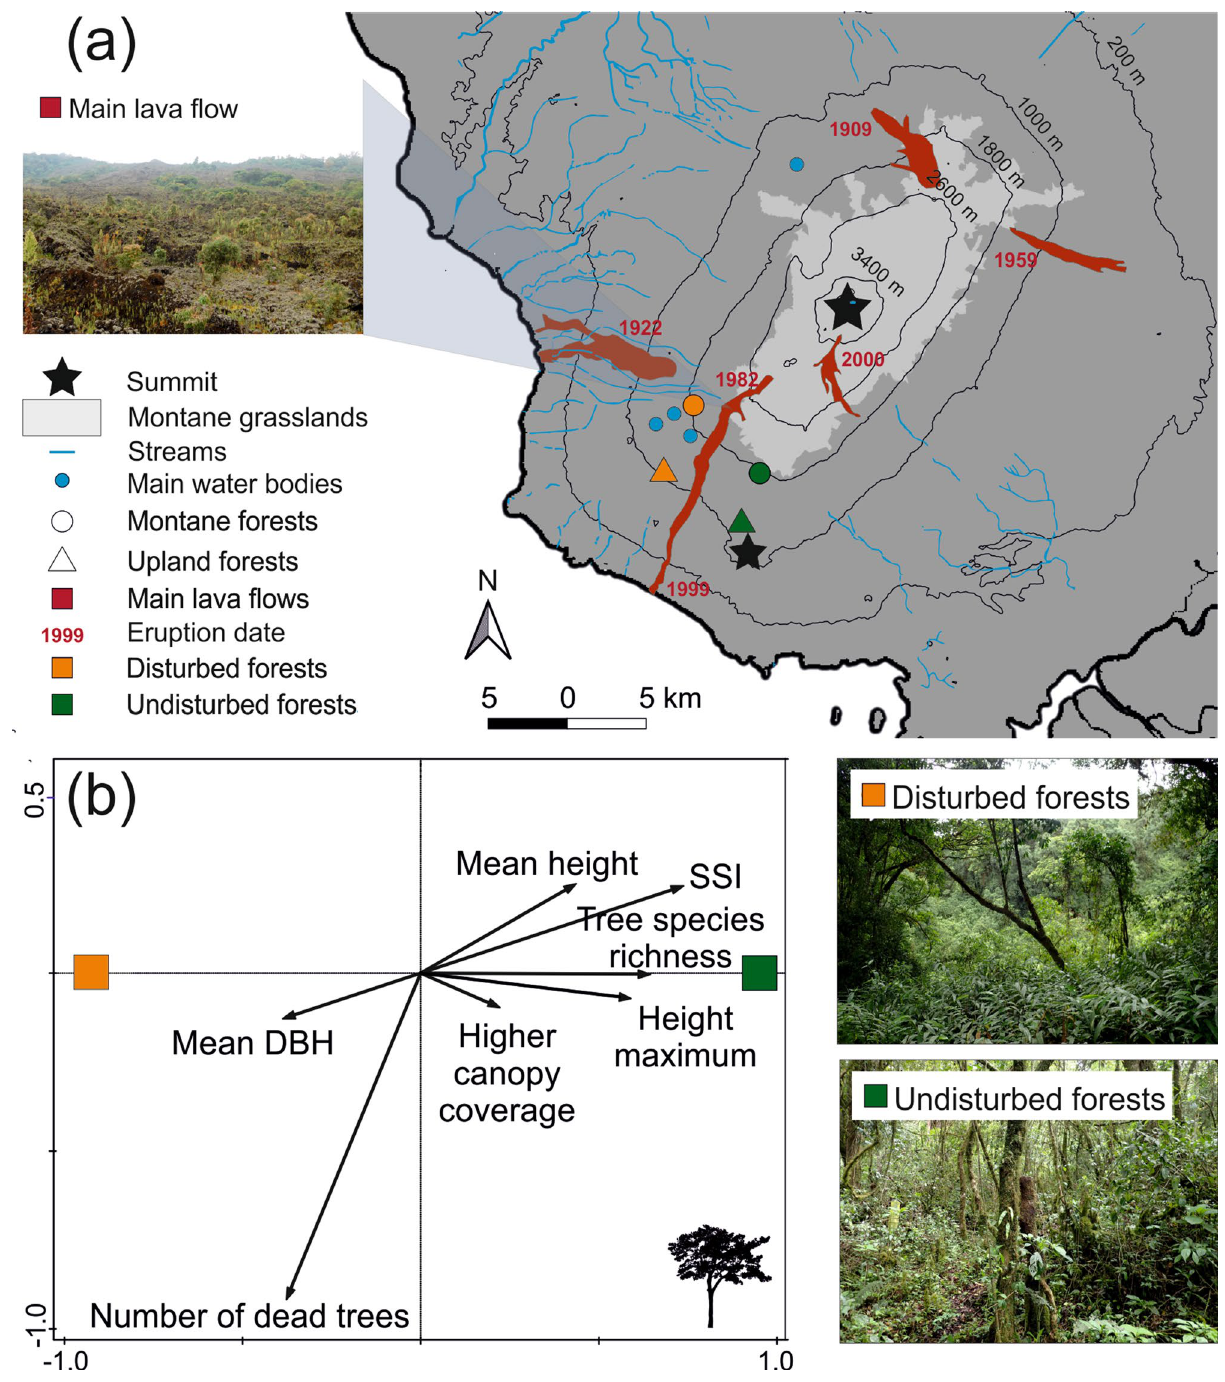
Figure 1. ( a ) Map of Mount Cameroon with the main lava flows, sampled forests and water resources. The background map was created in QGIS v. 3.10.0 ‘A Coruña’ (https ://qgis.org) and Corel Draw X7 (https ://www. corel draw.com). The pictures of disturbed and undisturbed forests were taken at the studied montane sites. ( b ) Redundancy analysis diagram visualizing effects of disturbances by elephants on forest